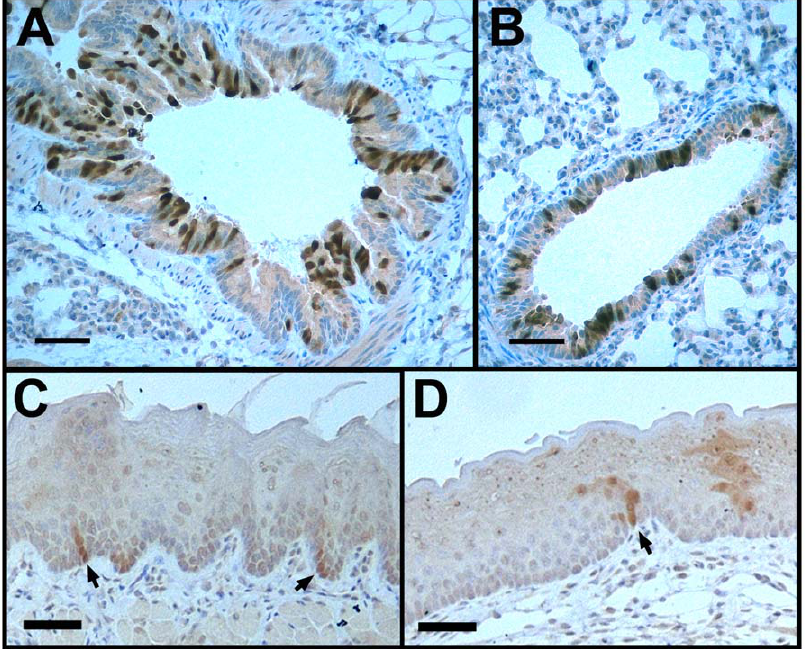
Figure 1. CK19 CreERT recombined an EYFP reporter in lung and oral cavity. Bronchus (A), bronchiole (B), lingual epithelium (C), and buccal epithelium (D) from CK19 CreERT ; R26R EYFP mice immunolabeled for EYFP (brown). Arrows in C and D, labeled cells in basal layer of epithelia. Size bars, 50 m m.